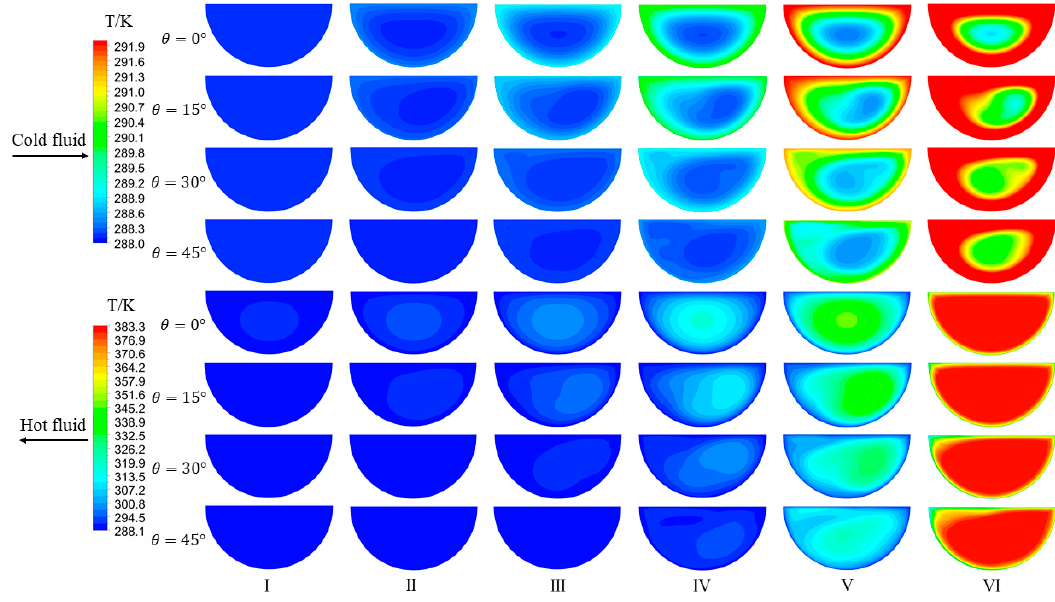
Figure 5. Temperature distribution of different cross-sections along the flow direction.